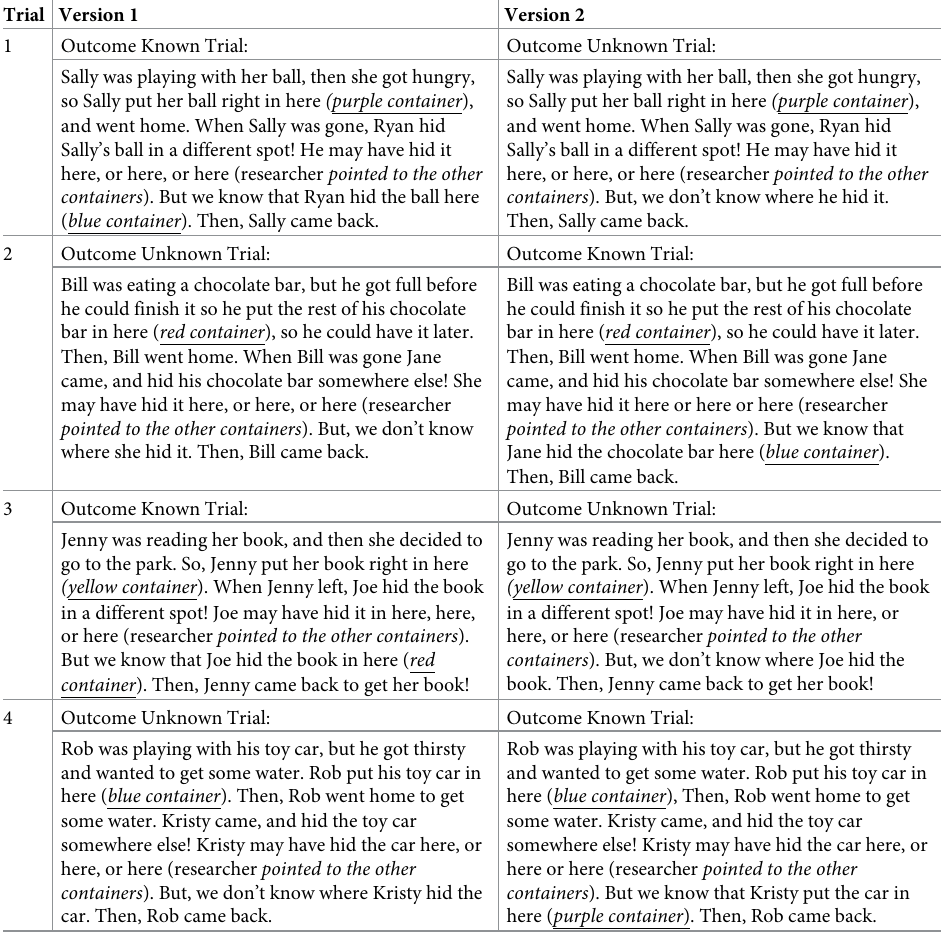
Table 1. The false belief scenarios presented by trial type and